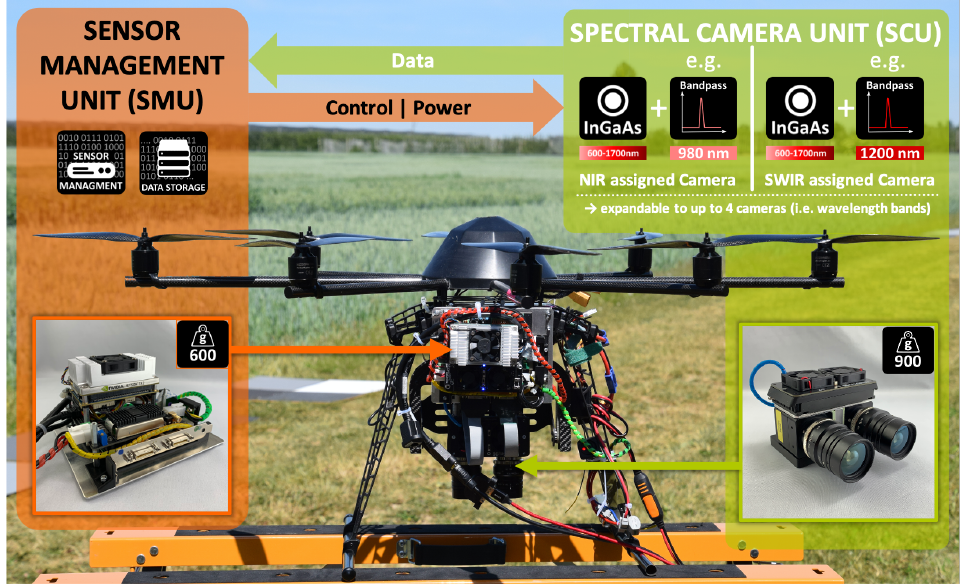
Figure 5. Overview of the VNIR/SWIR multi-camera imaging system mounted on a